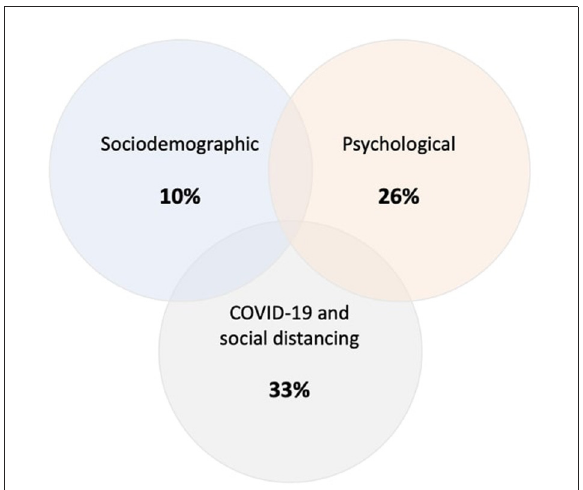
FIGURE2 Variance of social distancing adherence explained by sociodemographic, COVID-19 and social distancing related, and psychological determinants. The percentages represent R 2 that was derived from separate univariate models for each category. The total variance explained by sociodemographic, COVID-19 and social distancing related, and psychological determinants was